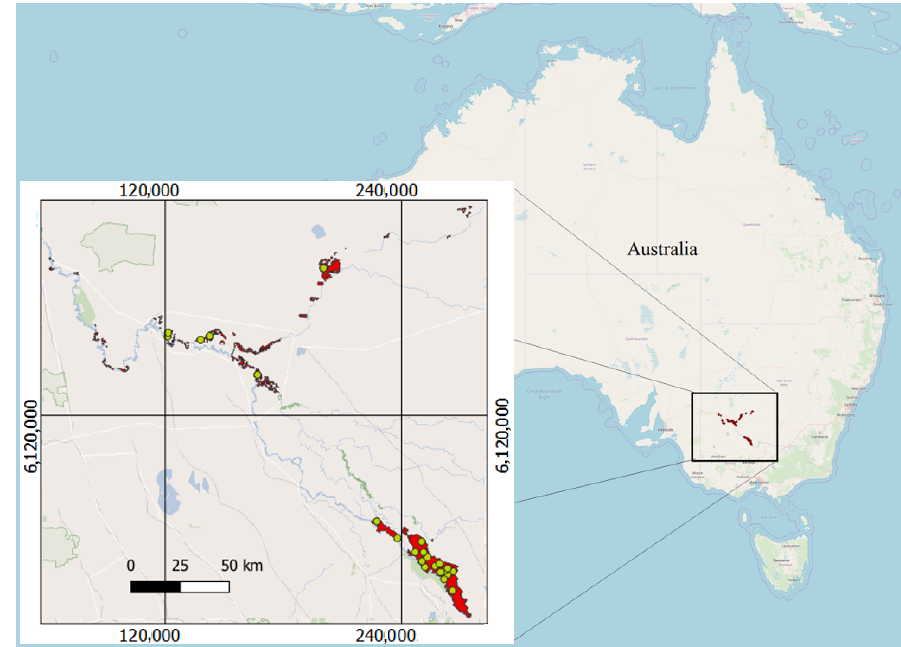
Figure 1. The study area used is depicted by red. The entire study area was scanned. The field plots used for evaluation were randomly scattered within that area and their locations are depicted with green